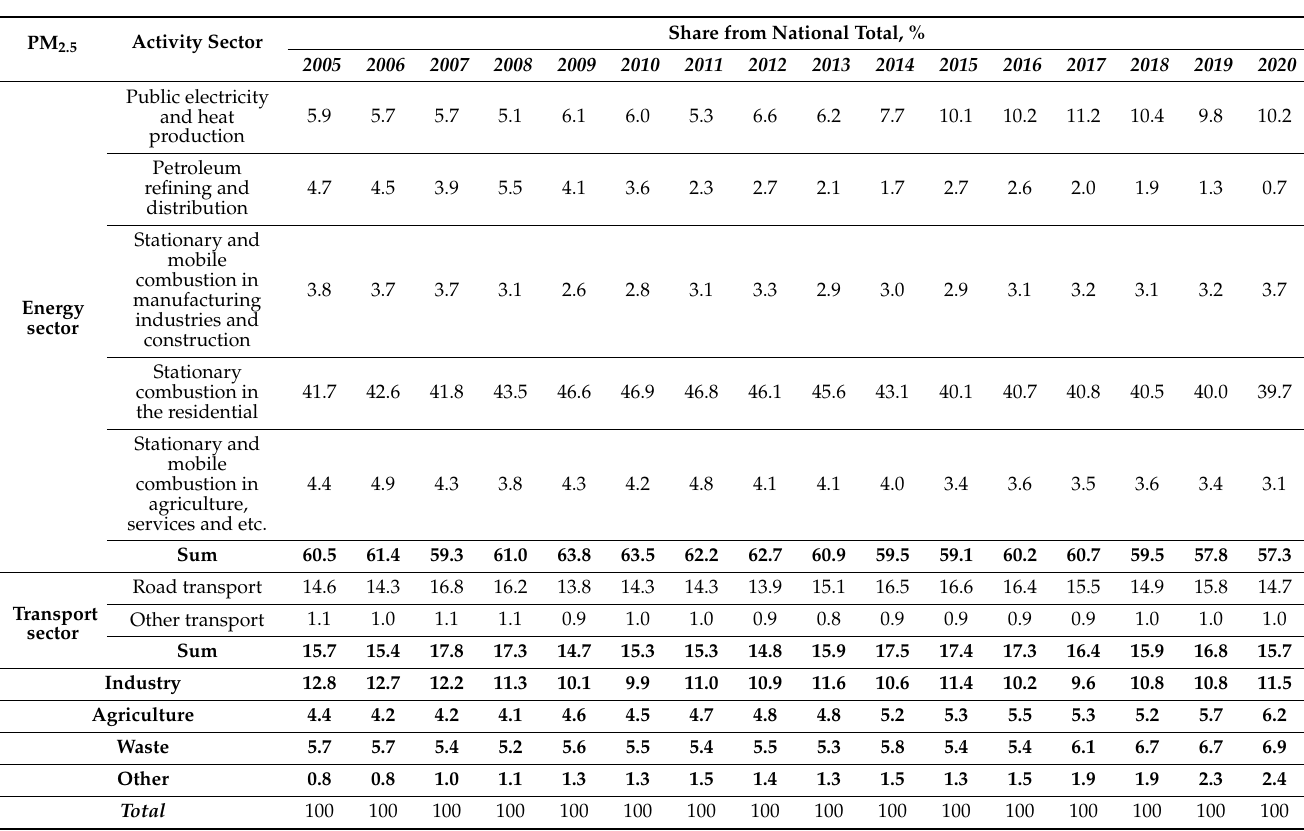
Table 2. Trend% in PM 2.5